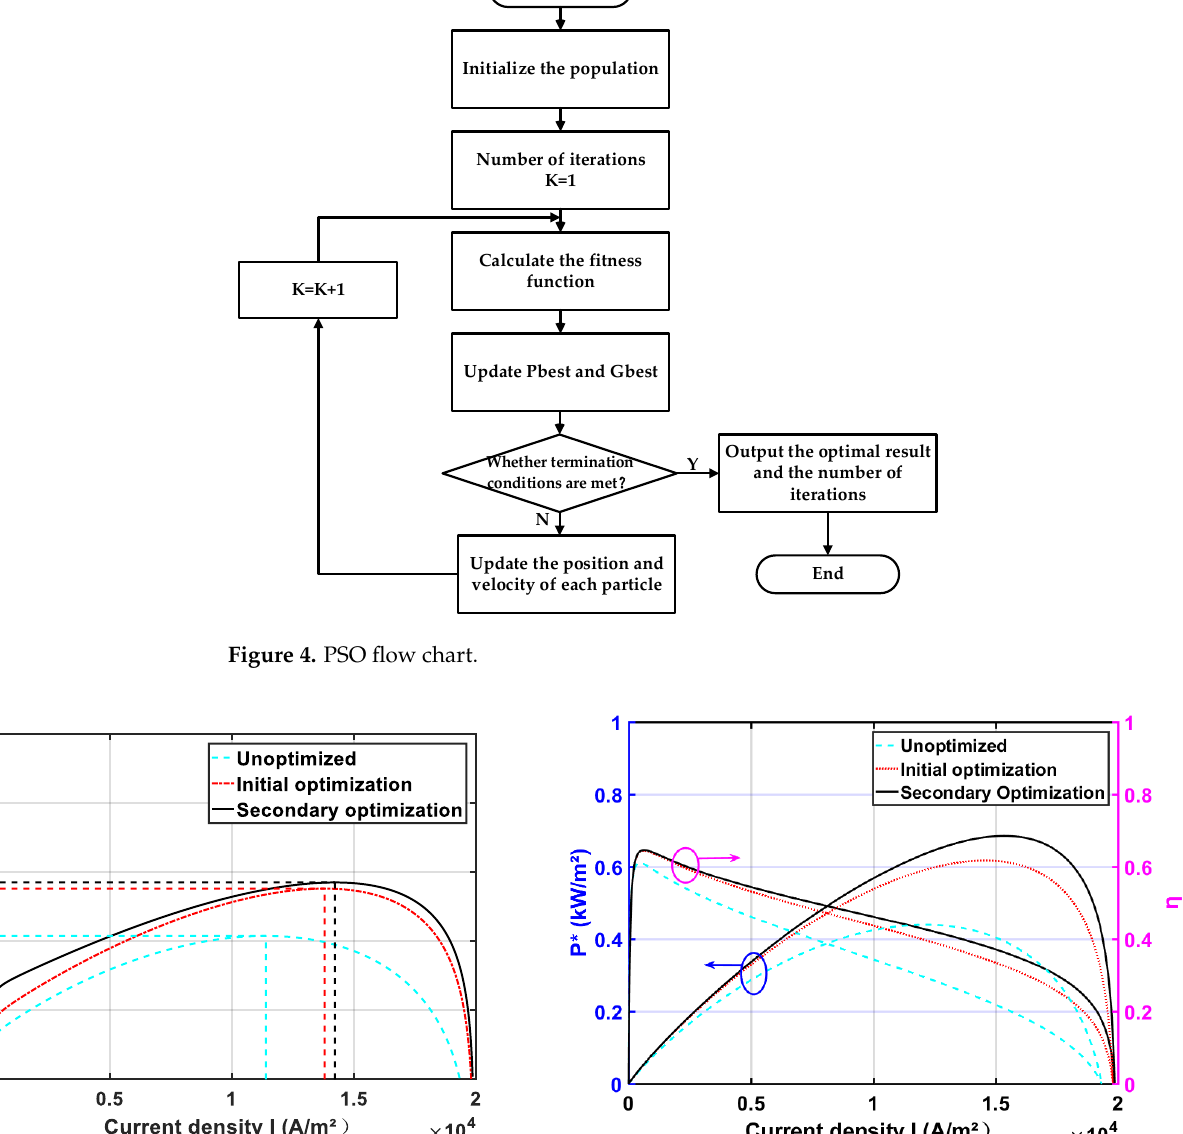
Figure 6. Comparison of 𝑃 ∗ and 𝜂 curves of the LT-PEMFC, HT-PEMFC, and optimized HT- PEMFC. 4. FCV Powertrain Design The powertrain parameters should be matched according to the vehicle parameters and design requirements. The vehicle parameters and design requirements are shown in Table 1.